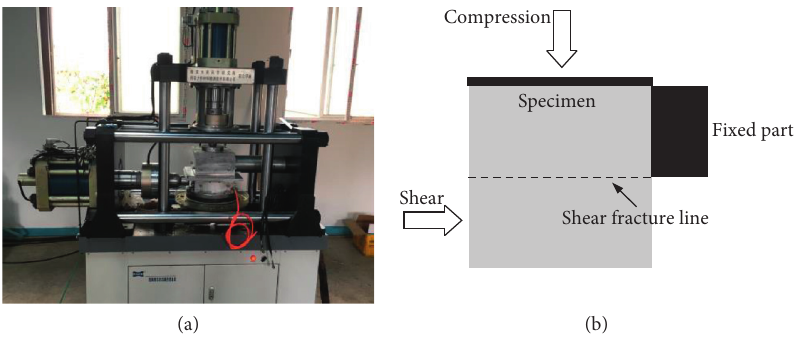
Figure 2: (a) Loading equipment and (b) loading schematic